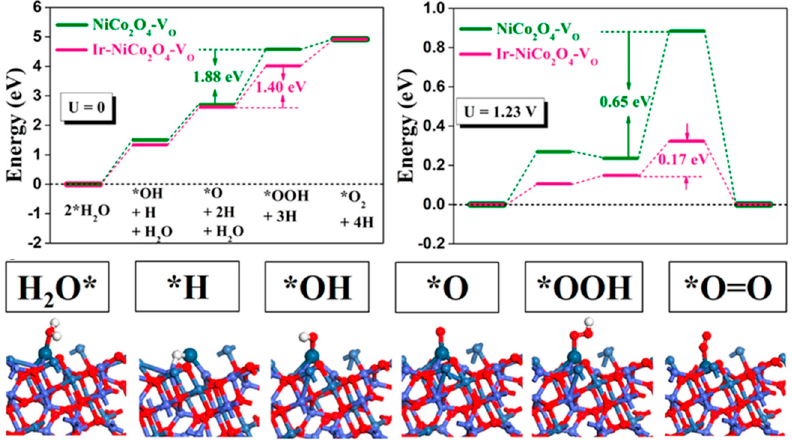
Figure 5. OER pathway under acidic conditions and local structural configurations of intermediates on the Ir − NiCo 2 O 4 − V O [28].